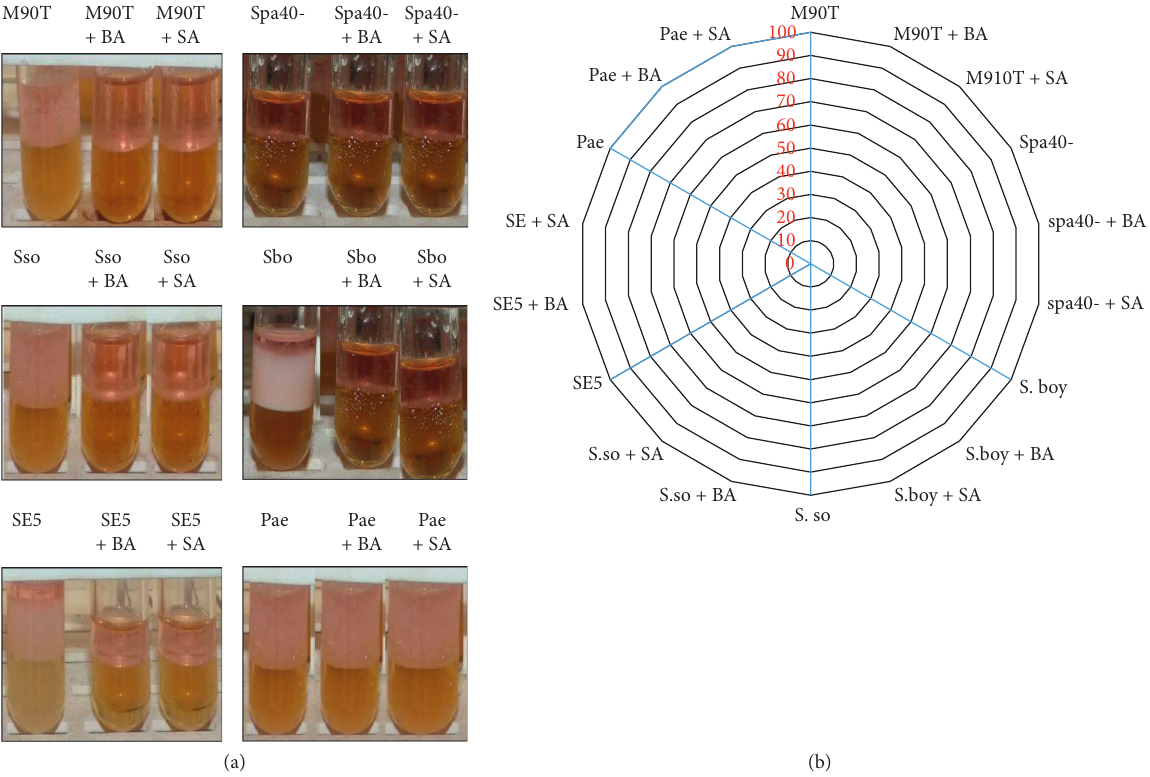
Figure 7: (a) Gasoline emulsifying activity of some Shigella strains used in this study with and without benzoic acid (BA) and salicylic acid (SA). M90T: S. flexneri strain M90T. spa40-: S. flexneri spa40 mutant, Sso: S. sonnei ; Sbo: S. boydii ; SE: Shigella sp. (environmental strain); Pae: P. aeruginosa. (b) Gasoline emulsifying activity appearances of some Shigella strains tested with and without benzoic acid or salicylic